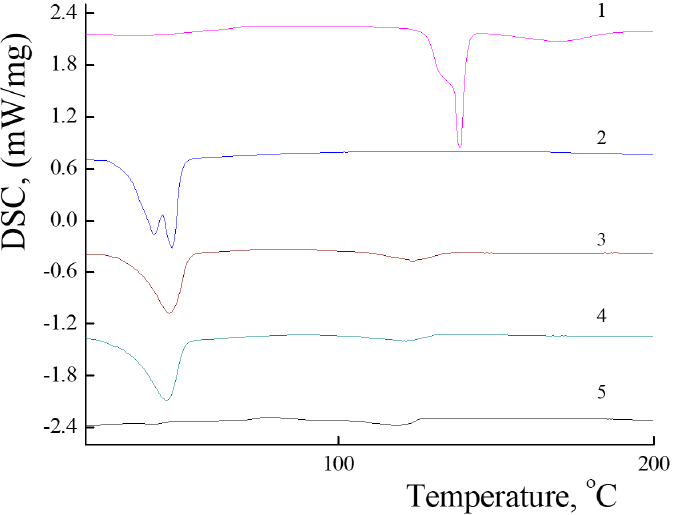
Figure 3. DSC curves for PLA-NH 2 (1); PLA-PEG (2); PLAMs–v (3); PLAMs–sb (4); and PLAMs–us (5). Heating rate 10 °C/min.